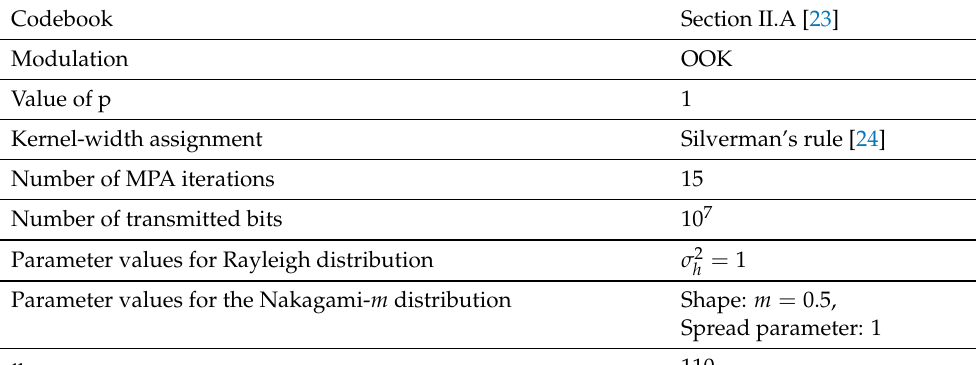
Figure 4. BER vs. SNR comparison of the Bussgang-based detector with RFF-based detector for a Rayleigh Channel by varying the number of pilots. Table 1. Simulation